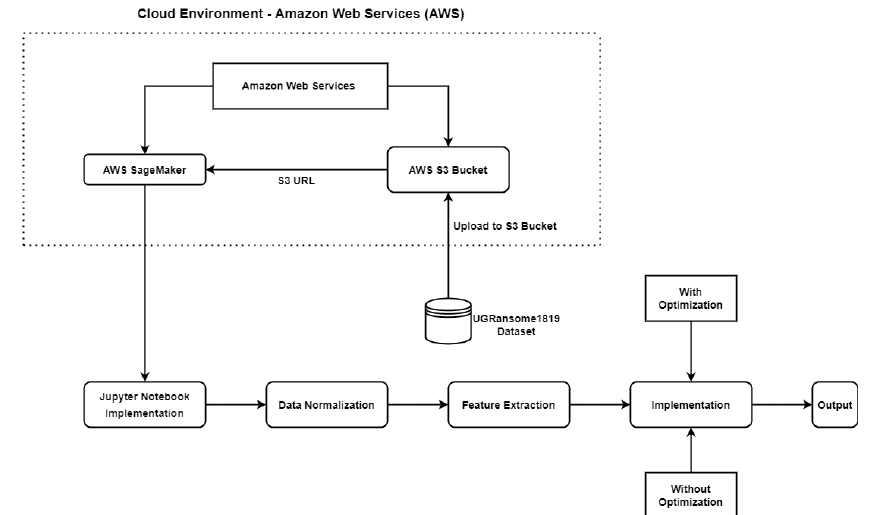
Figure 2. The Cloud Based Optimisation Method